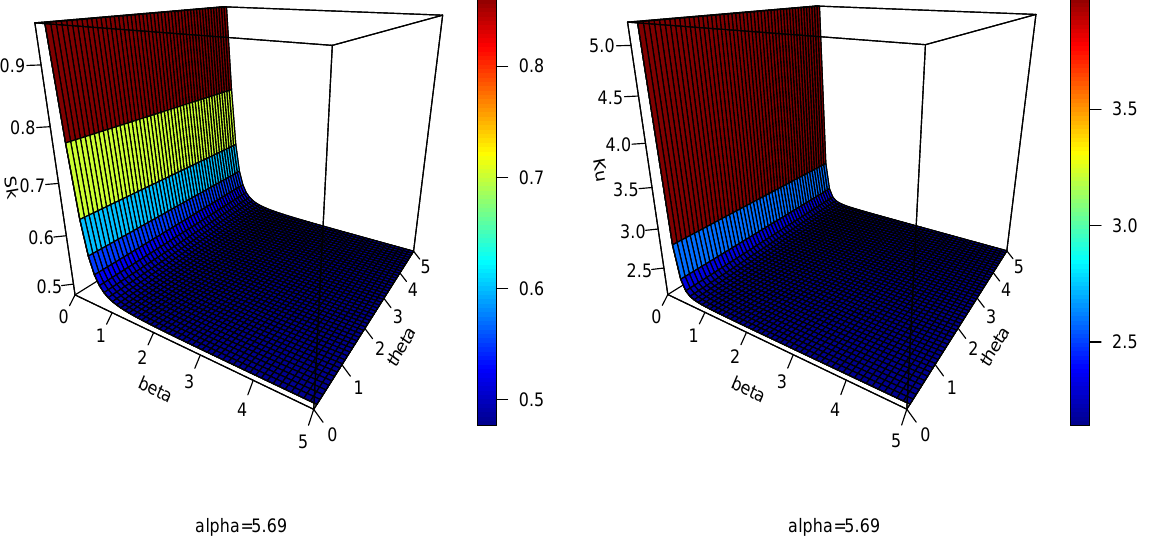
Figure 3. Plots of Galton’s skewness (Sk) and Moor’s kurtosis (Ku) for the EPAIG-ED.